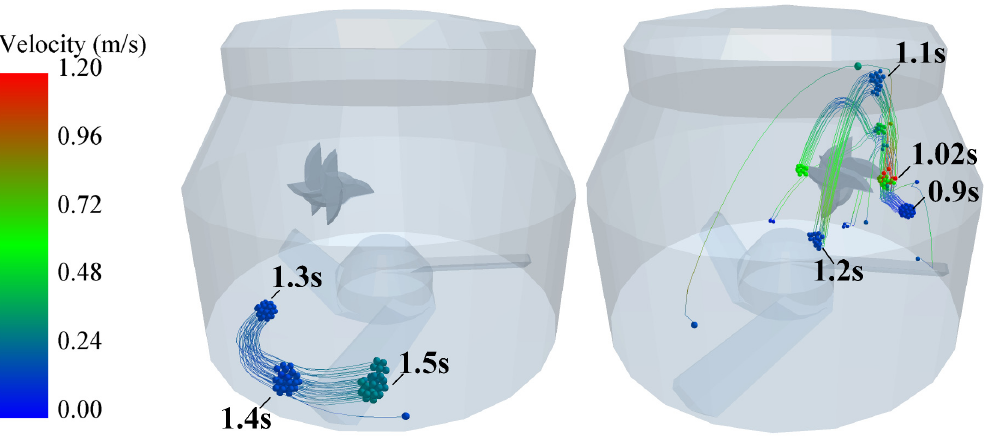
Figure 9. Breakage track diagram.